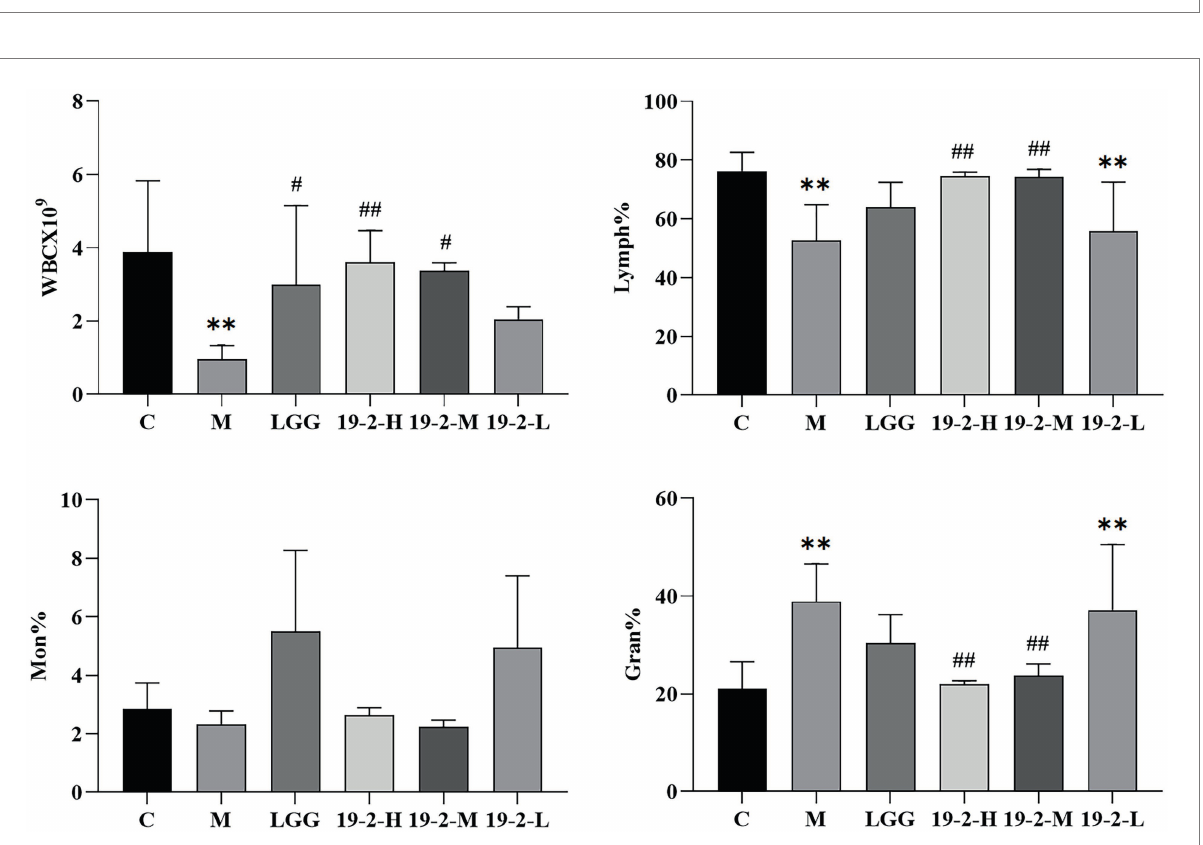
FIGURE 4 Comparison of WBC, lymphatic %, Mon%, and Gran% in blood of each group. ** showed significant difference compared with the control group, p < 0.01; ##, # represent significant difference compared with group M, p < 0.01, p < 0.05.